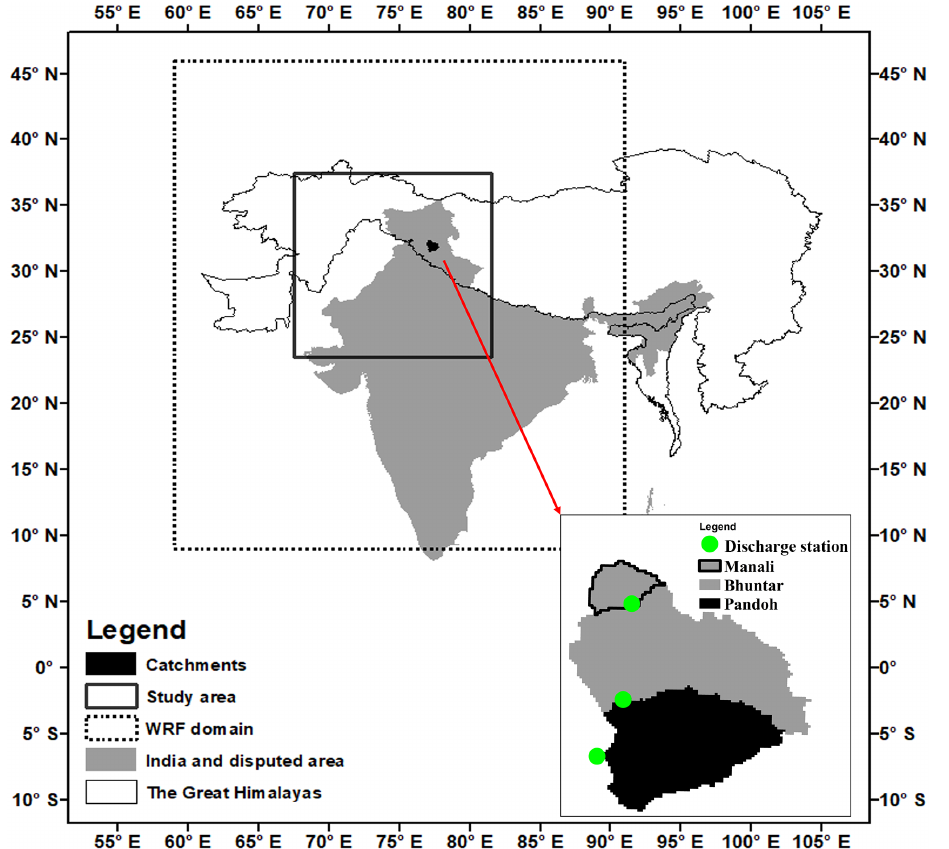
Figure 1. Location map of the study area, the Bhuntar rain gauge and three discharge stations.